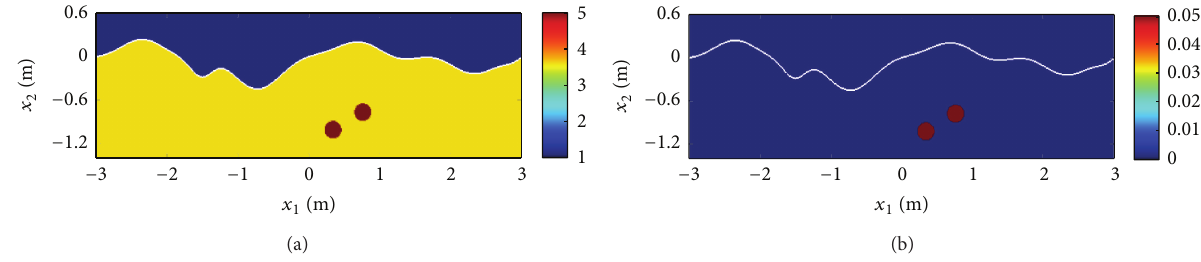
Figure 3: (a) The exact relative permittivity and (b) conductivity profiles of two circular objects and the background.